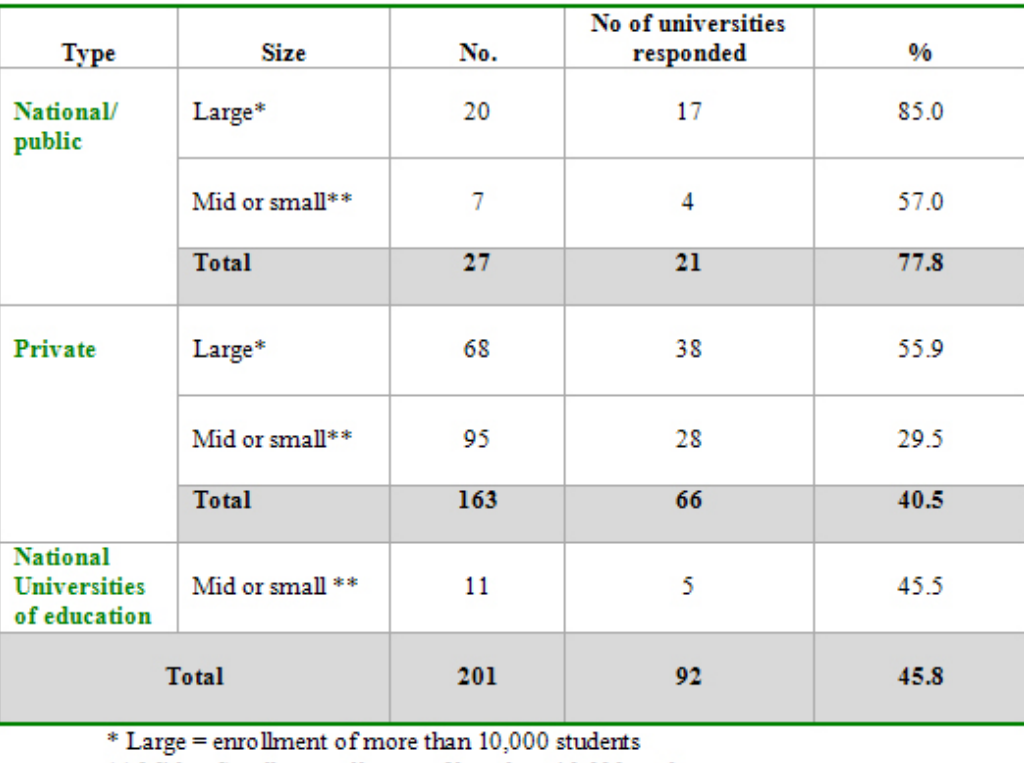
Table 1. Response Stated by Type and